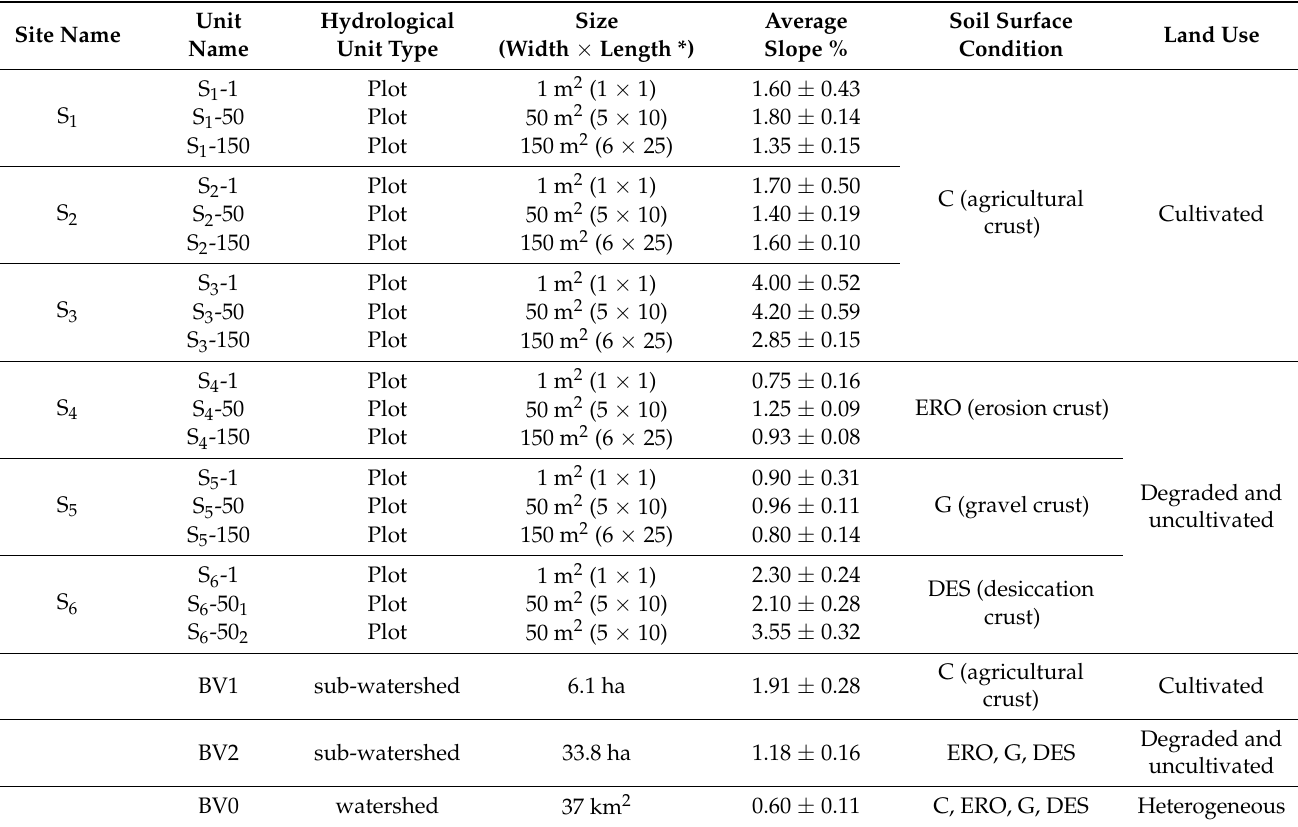
Table 1. Description of the experimental setup used in the present